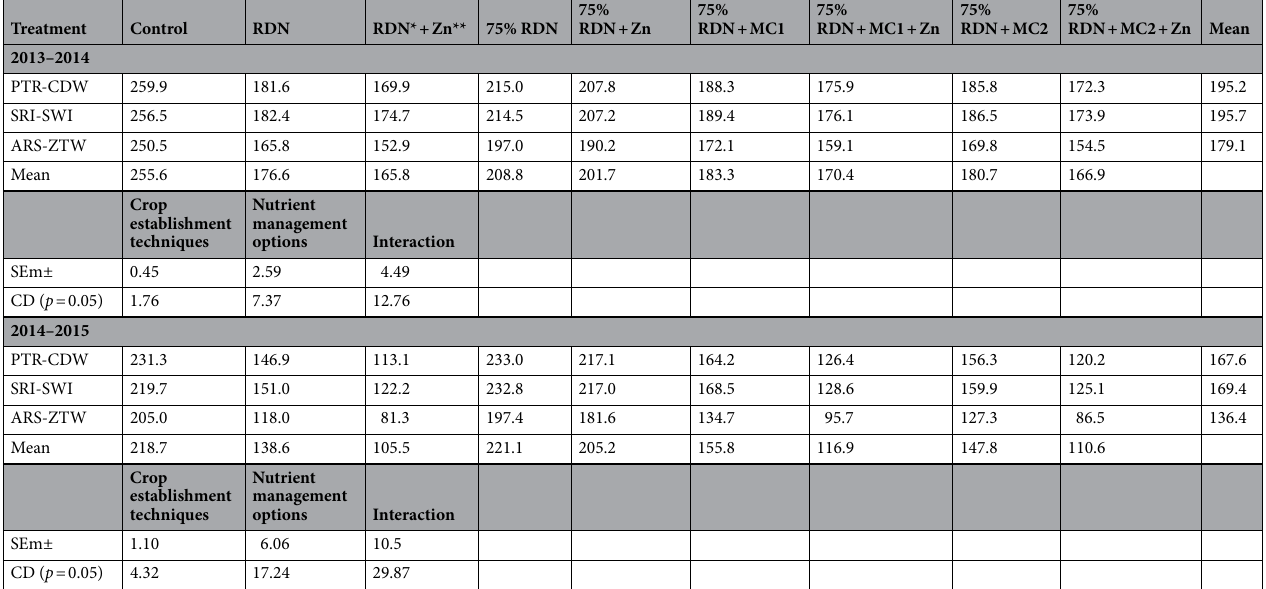
Table 8. Influence of crop establishment techniques and nutrient management options on soil potassium (kg K ha −1 ) (NH 4 OAC-extractable) after completion of first and second cycle of rice–wheat cropping system. PTR , puddled transplanted rice; SRI , system of rice intensification; ARS , aerobic rice system; CDW , conventional drill-sown wheat; SWI , system of wheat intensification; ZTW , zero tillage wheat; RDN* , recommended dose of nutrients [120 kg nitrogen ha −1 and 25.8 kg phosphorus (P) ha −1 per crop]; Zn** , 5